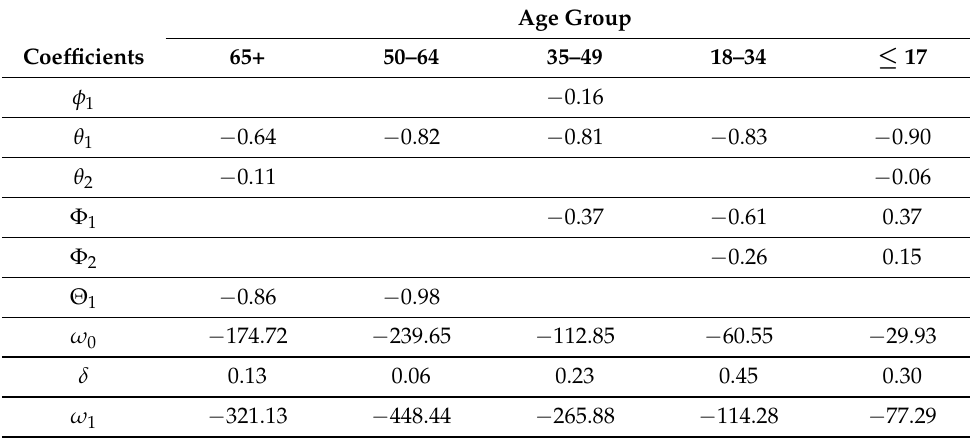
Table A3. ITSA model parameter estimates for age groups.